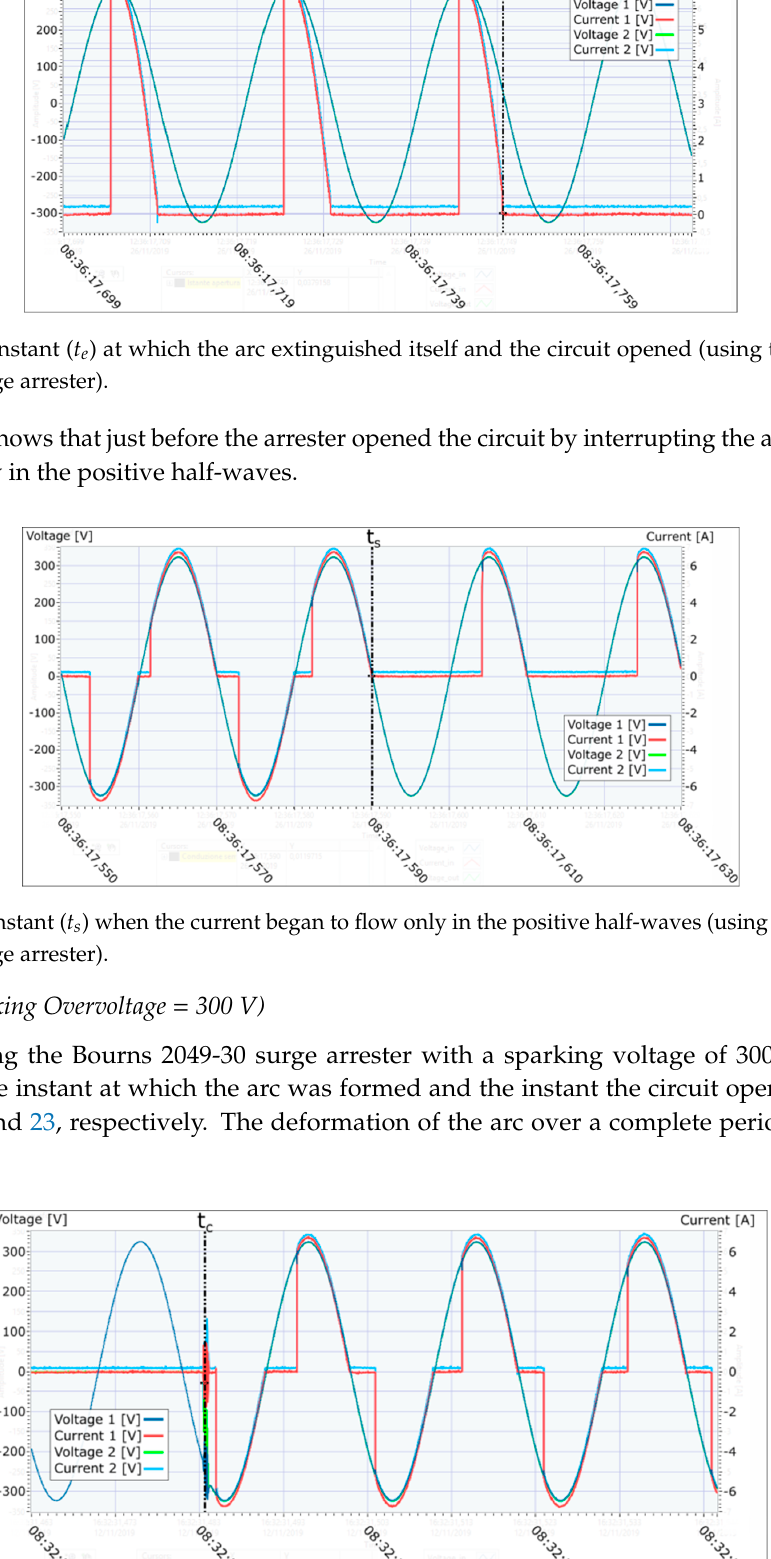
Figure 22. Instant ( t c ) at which the arc was formed (using the Bourns 2049-30 surge arrester).